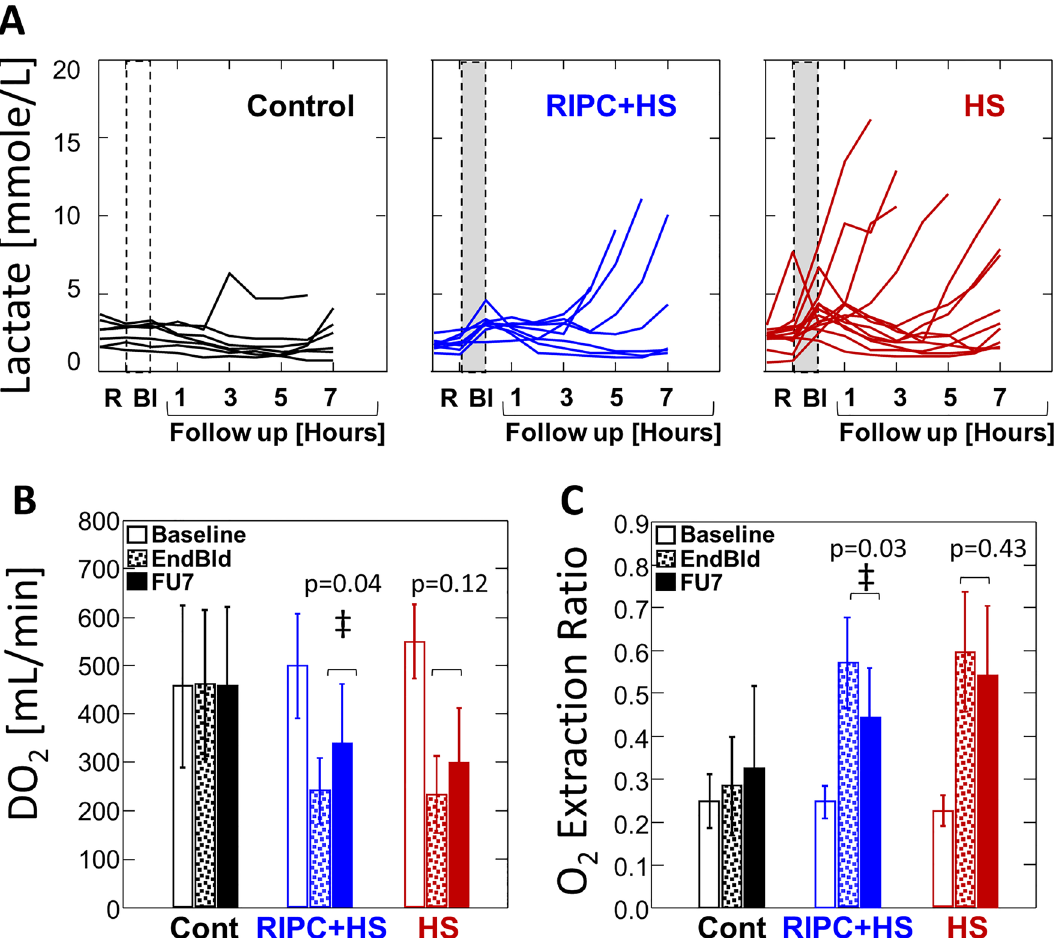
Figure 3. Analysis by Survivors. Change in mean arterial pressure (MAP), cardiac index (Cardiac Ind.), global oxygen delivery (DO 2 ), and oxygen extraction ratio for controls, animals that underwent bleeding (HS) and those that received RIPC prior to bleeding (RIPC + HS) at 2, 4, and 6 h follow-up compared to end of bleeding restricted to animals that survived at each time. #animals: Controls: n = 7; HS n = 13, 10, 9 at 2 h, 4 h, 6 h; RIPC + HS n = 8, 8, 5 at 2 h, 4 h, 6